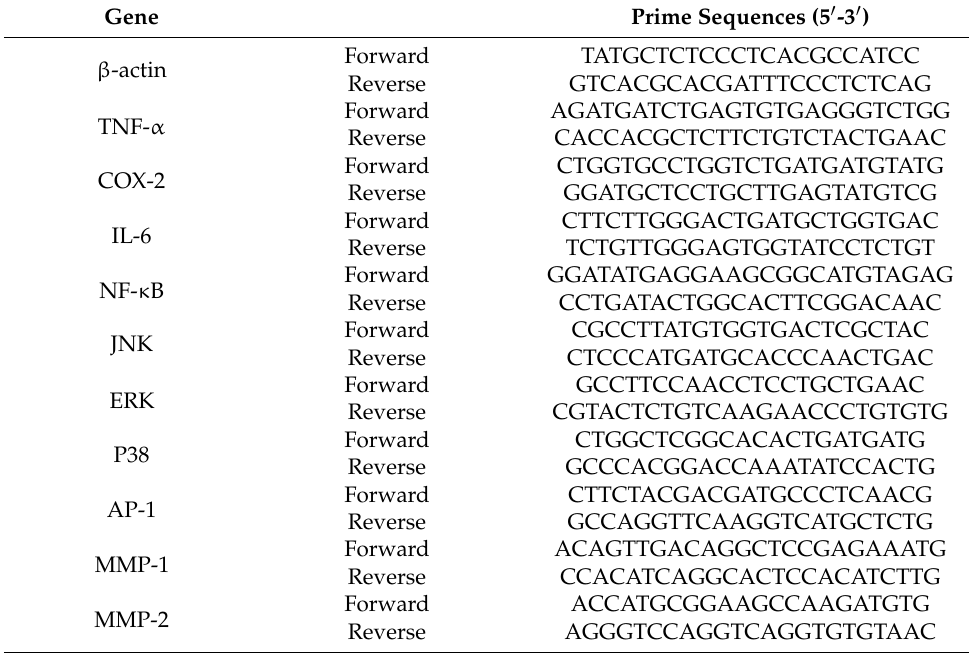
Table 3. Real-time quantitative PCR primer sequences. Gene Prime Sequences (5 (cid:48) -3 (cid:48)